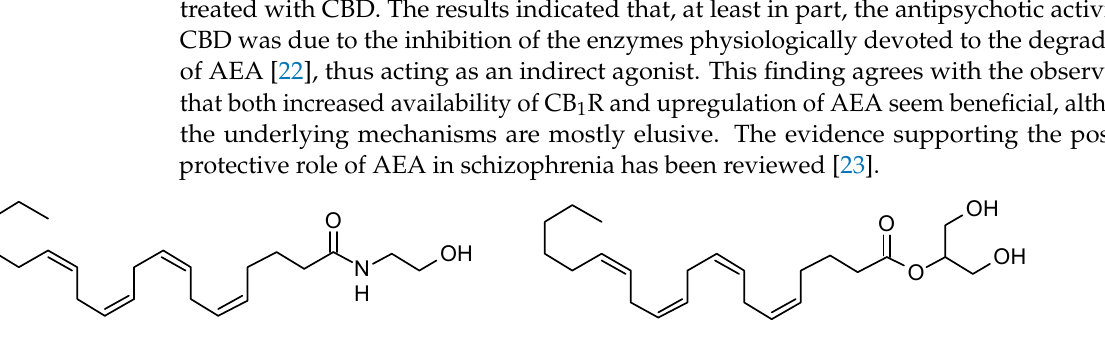
Figure 2. Chemical structures of N -arachidonoylethanolamine (anandamide, AEA, 3 ) and 2-arachidonoylglycerol (2-AG, 4 ).